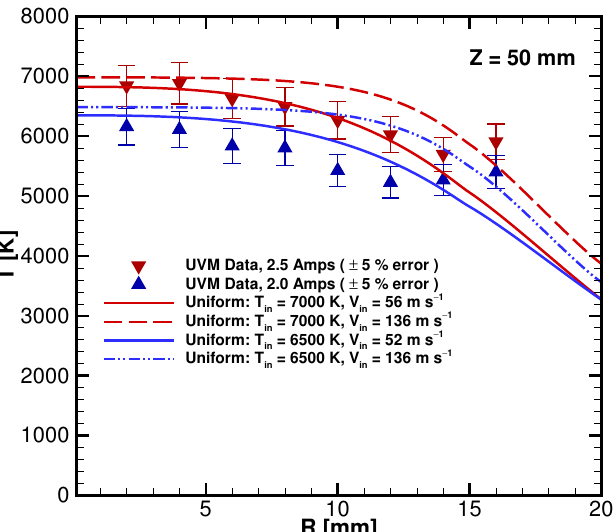
Figure 9. Plasma temperature measurements and simulated values at Z = 50 mm downstream of the torch outlet.